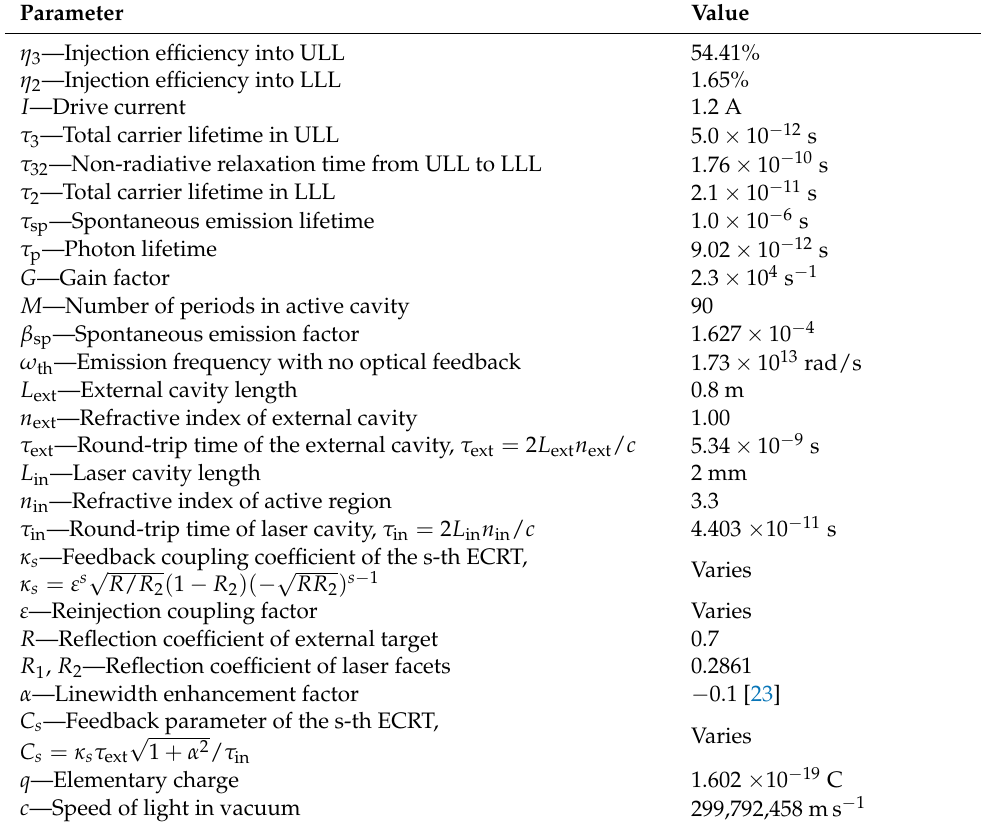
Table 1. Parameters used in Equations